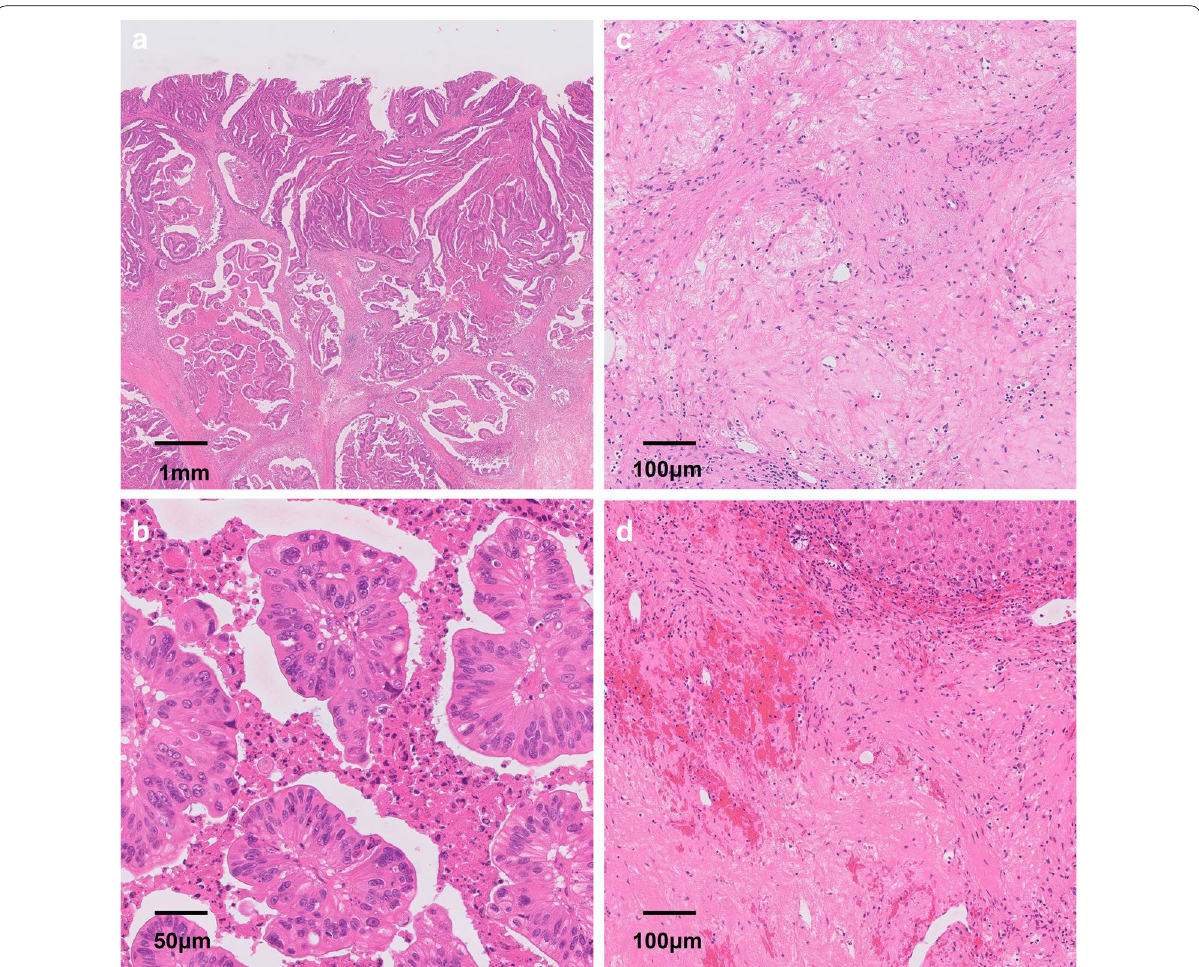
Fig. 5 Pathological findings. a Primary tumor of the resected stomach is composed of well-differentiated adenocarcinoma invading to the muscularis propria (ypT2). b The majority of tumor cells are viable (grade 1a). No viable tumor cells are seen in the specimens resected from liver segments 3 ( c ) and 4 ( d